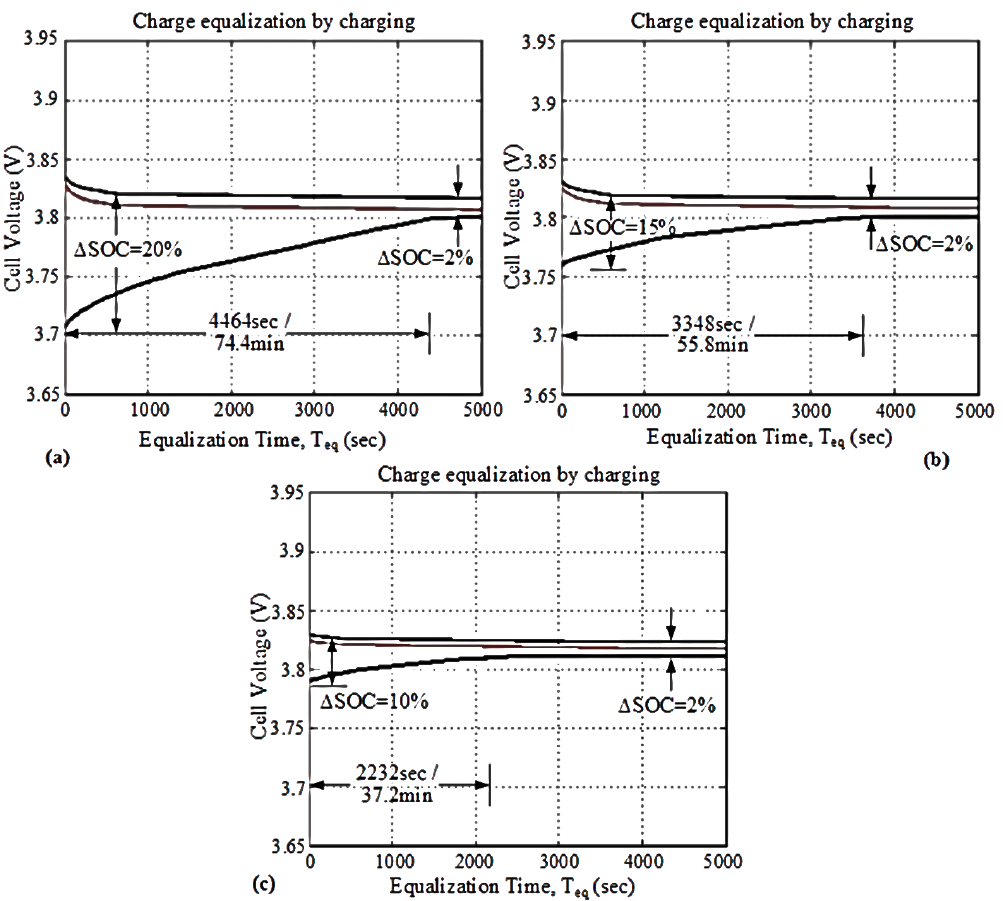
Figure 11. Battery charge equalization performance ( a ) charge with 20% SOC difference; ( b ) charge with 15% SOC difference; ( c ) charge with 10% SOC difference.